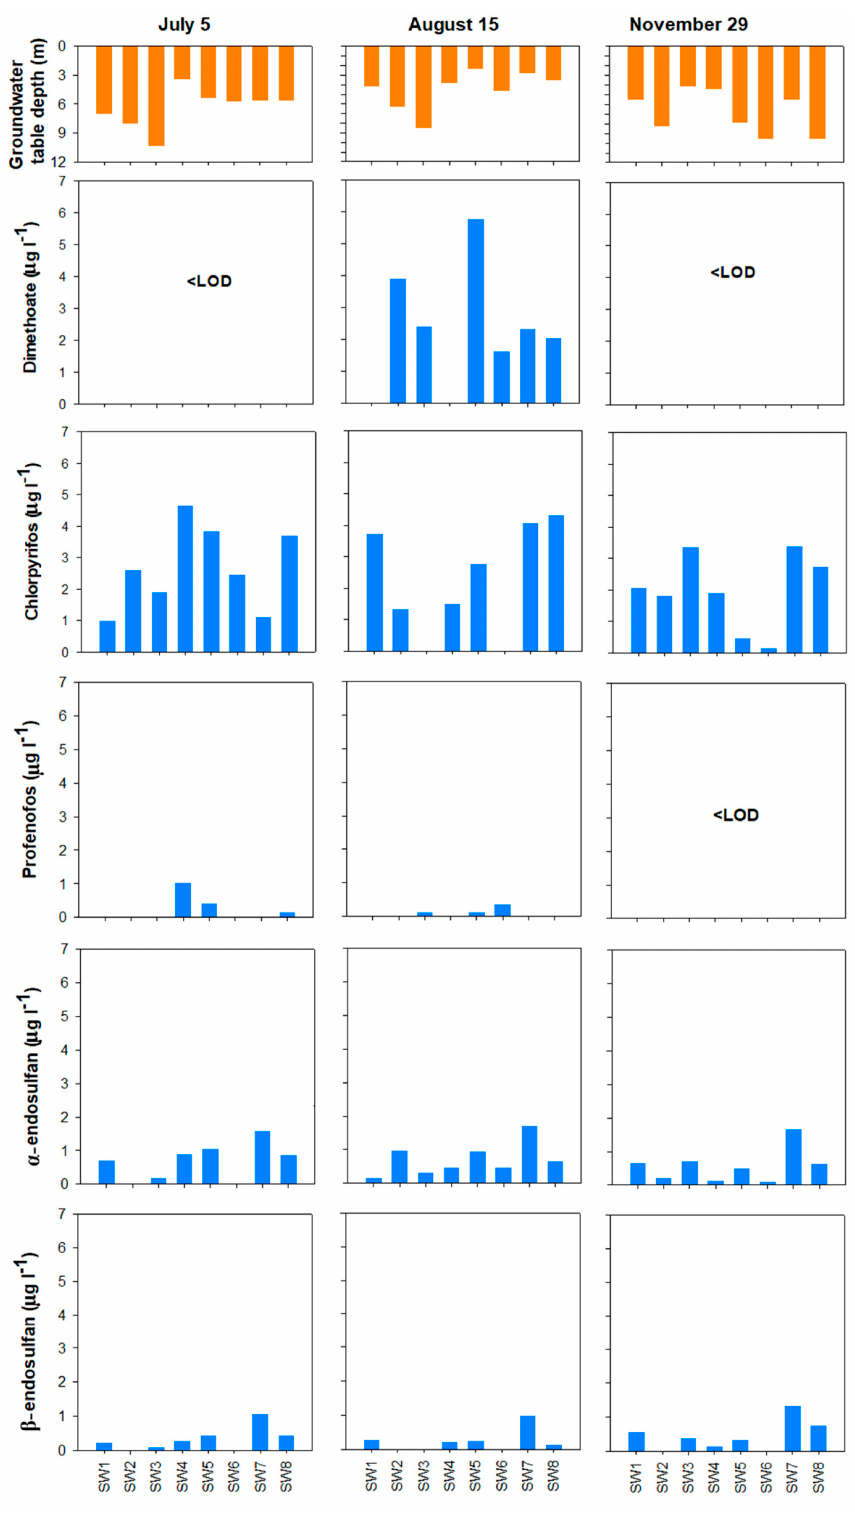
Figure 4. Pesticide concentrations in wells SW1–SW8 during dry and rain phases. The well locations are given in Figure 1.